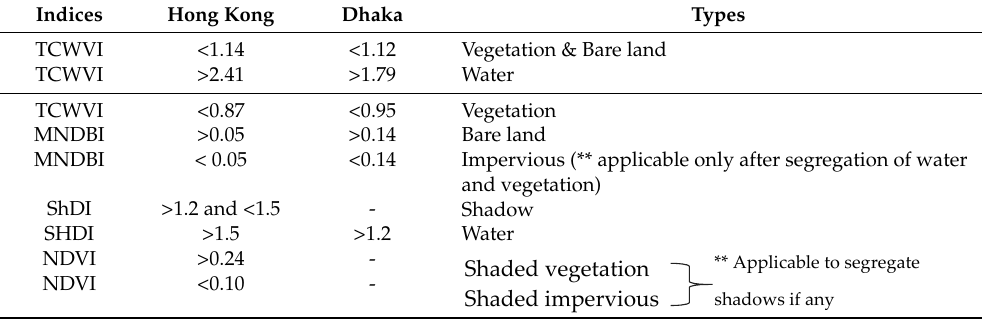
Figure 9. Workflow for the proposed land cover classification procedure. Table 3. Optimized thresholds of the land cover classes.